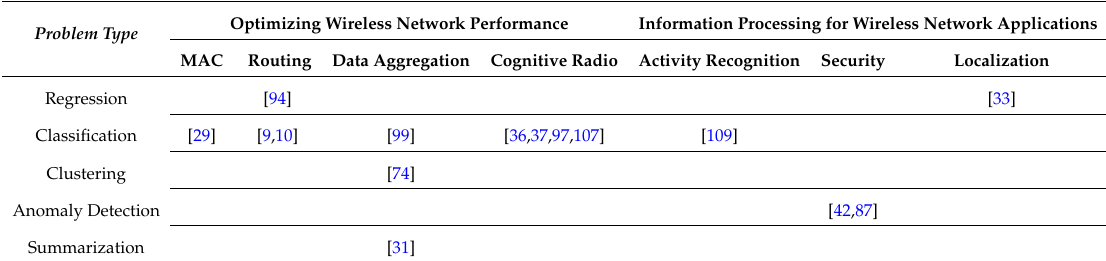
Table 2. Summary of various data science applications in wireless